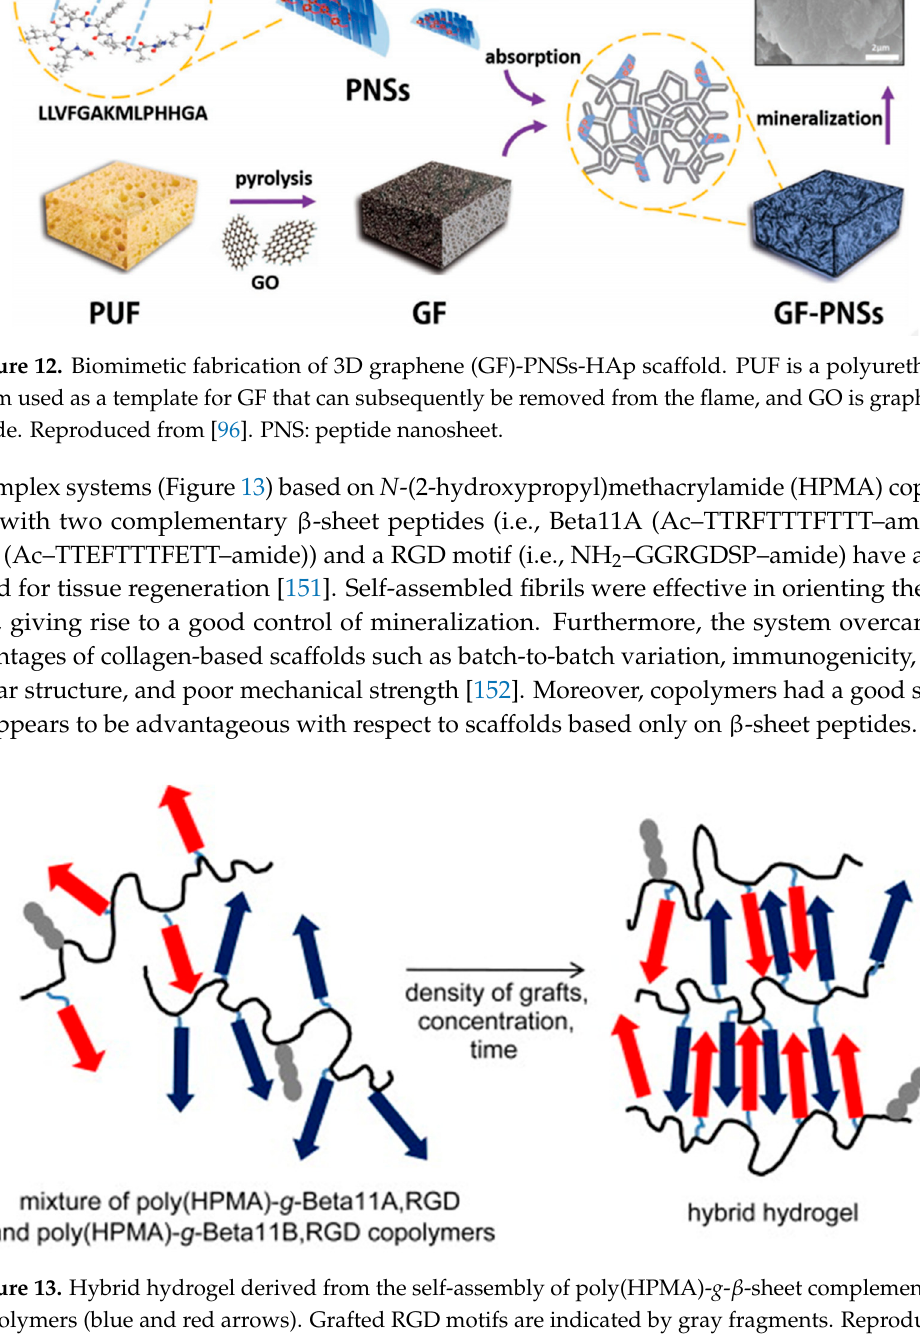
Figure 11. Chemical structure of the self-assembled SPG-178 peptide and scheme showing the corresponding hydrogel formation. Scale bar = 100 nm. Scheme based on [135].